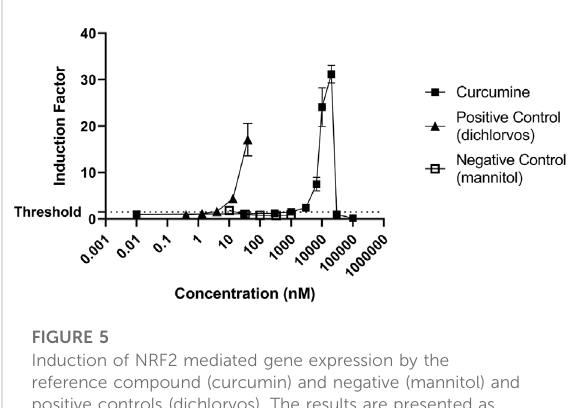
FIGURE 5 Induction of NRF2 mediated gene expression by the reference compound (curcumin) and negative (mannitol) and positive controls (dichlorvos). The results are presented as induction factor, the fold induction over the solvent control. Thedataarepresentedasmeanvalues±S.D.ofthreeindependent